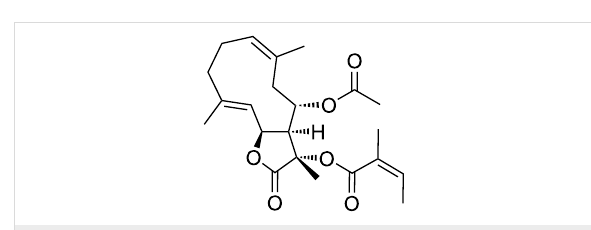
Figure 10: Structure of